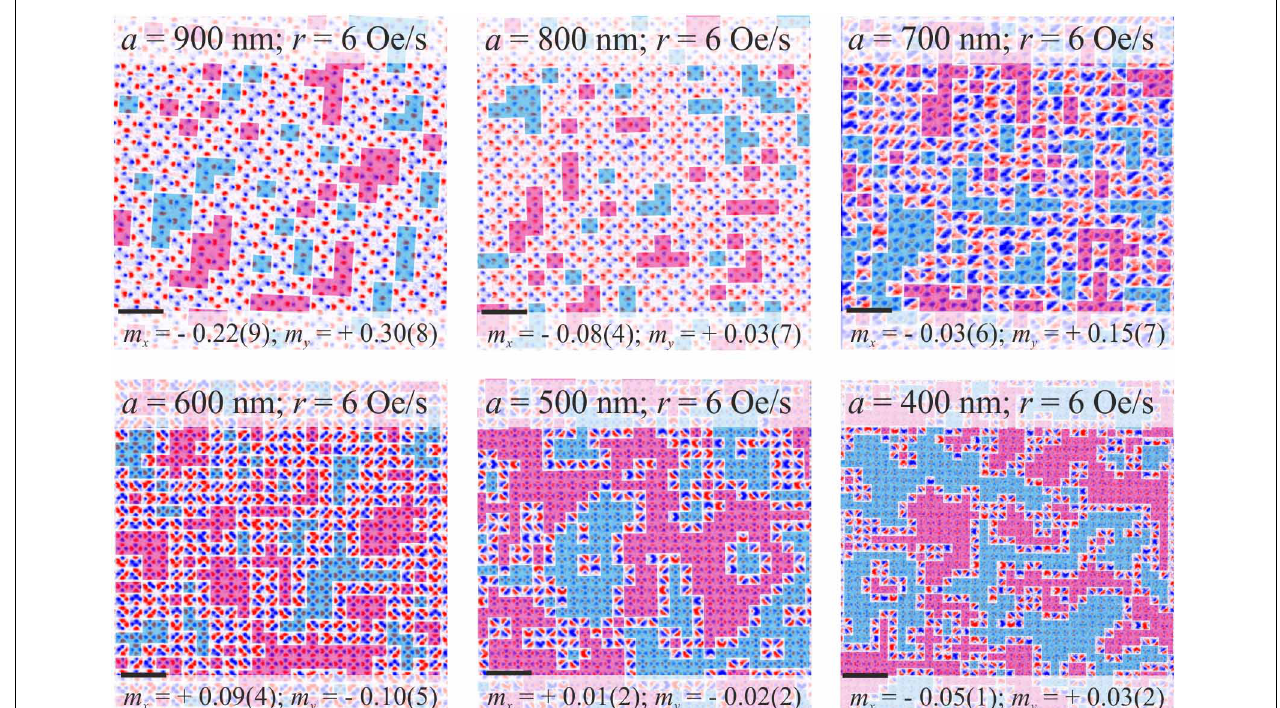
FIGURE 3 | MFM images of square ice states prepared by a linearly decreasing rotating in-plane field. Scale bars represent 2 µ m. Samples were rotated at f = 42Hz, and the field was ramped down at r = 6 Oe/s. As the lattice constant decreases from a = 900nm to 400nm, strong ground state order emerges in the form of well-defined